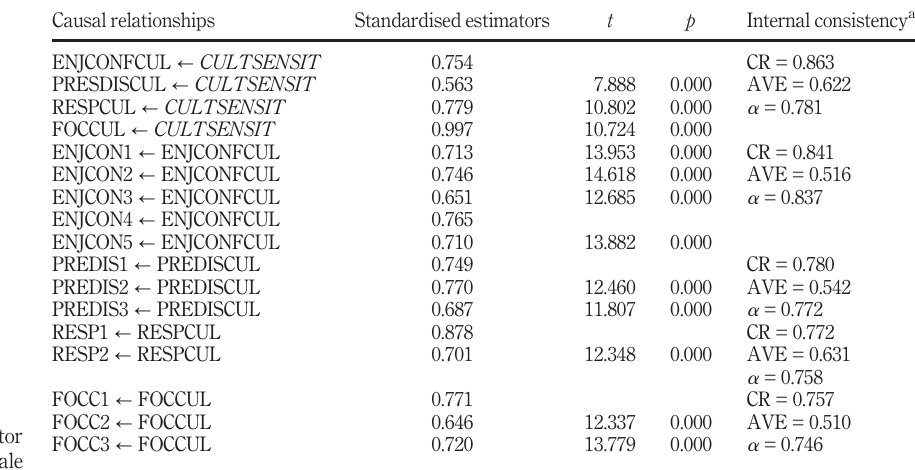
Table IV. Con fi rmatory factor analysis of the scale of cultural sensitivity